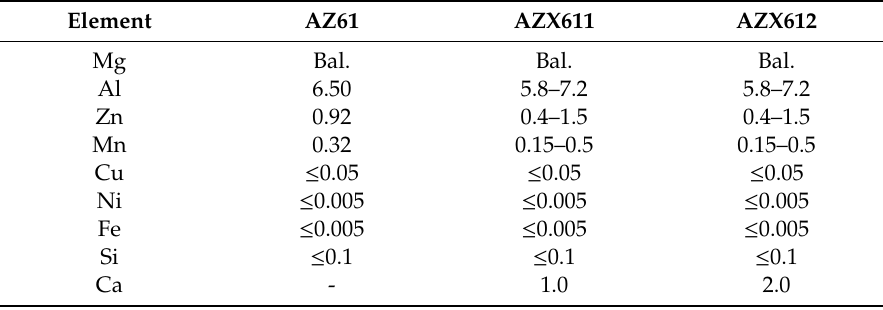
Table 1. Chemical composition of the